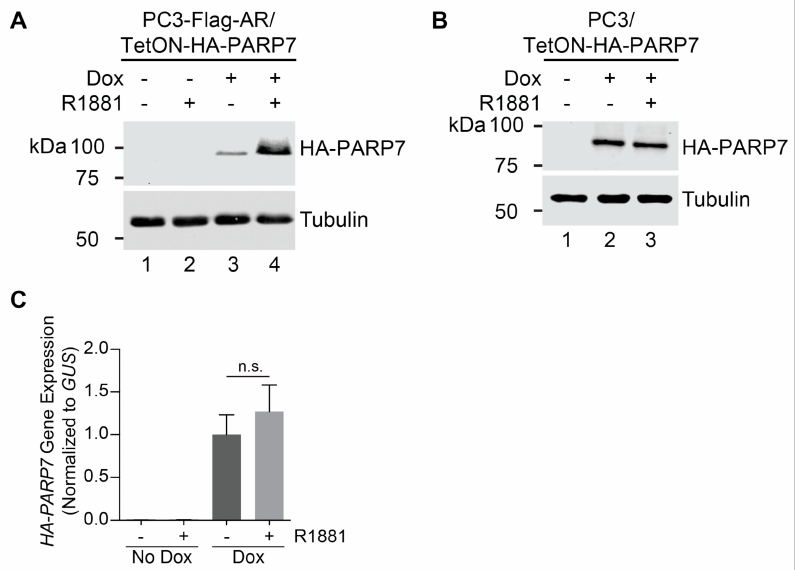
Figure 1. Androgen receptor (AR) signaling can increase PARP7 protein level independent of PARP7 transcript level. ( A ) PC3 cells stably expressing EF1 α -driven Flag-tagged AR and